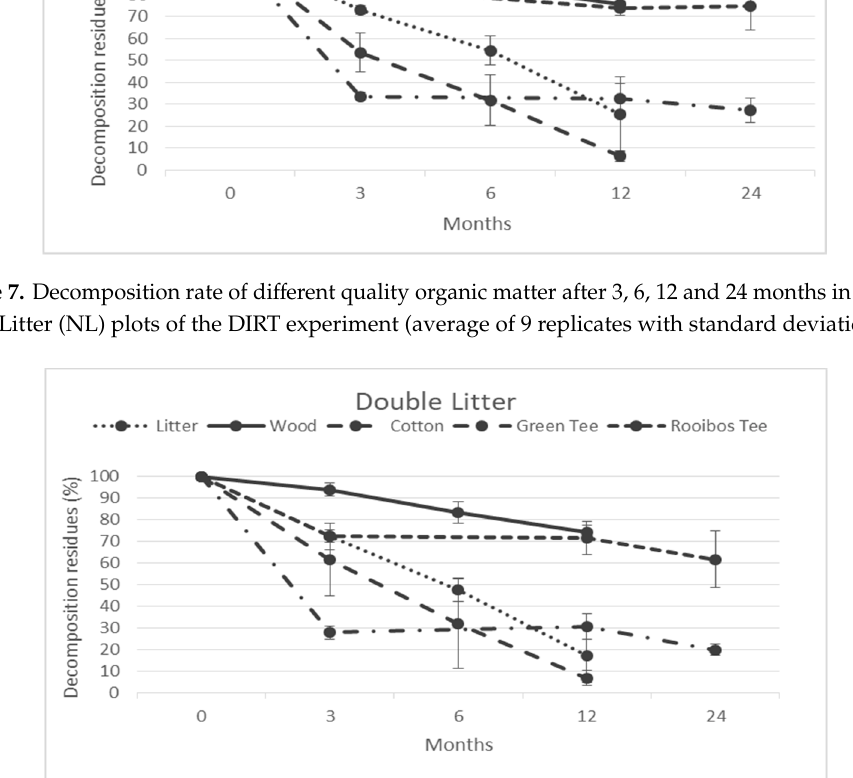
Figure 8. Decomposition rate of different quality organic matter after 3, 6, 12 and 24 months in the soils of Double Litter (DL) plots of the DIRT experiment (average of 9 replicates with standard deviation).